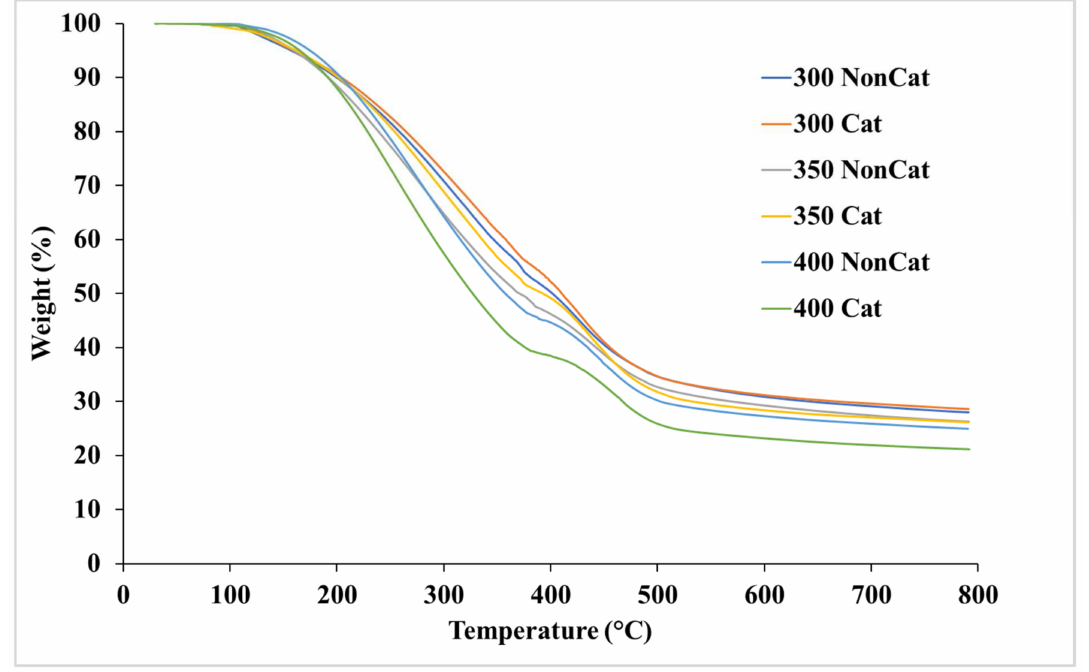
Figure 4. Volatility curves of